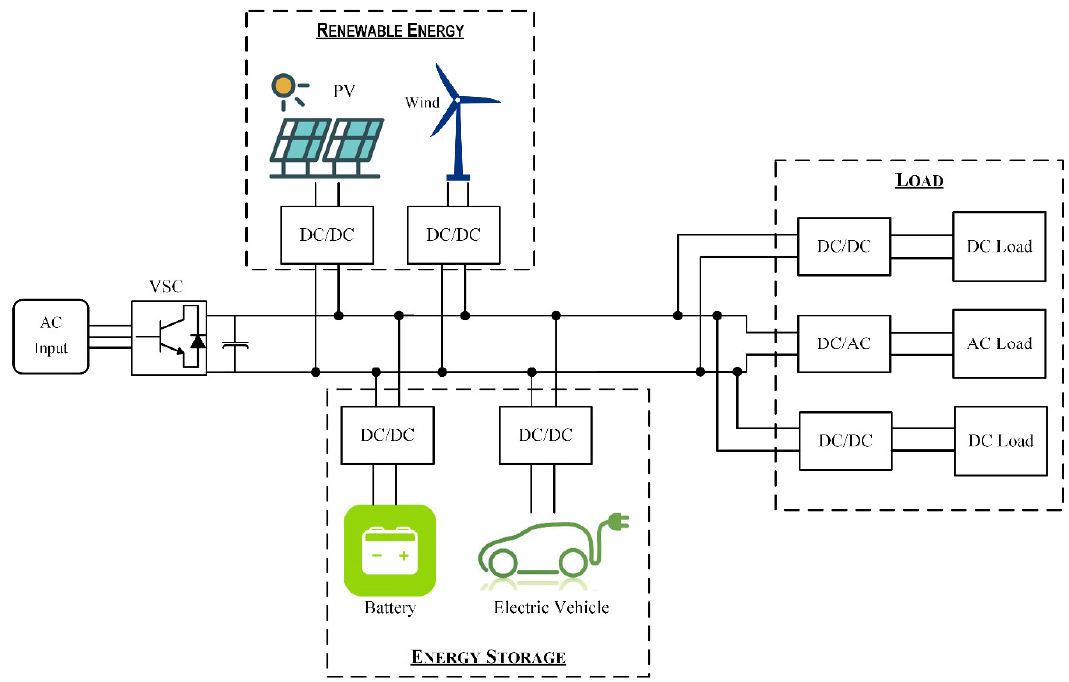
Figure 1. DC single bus configuration.